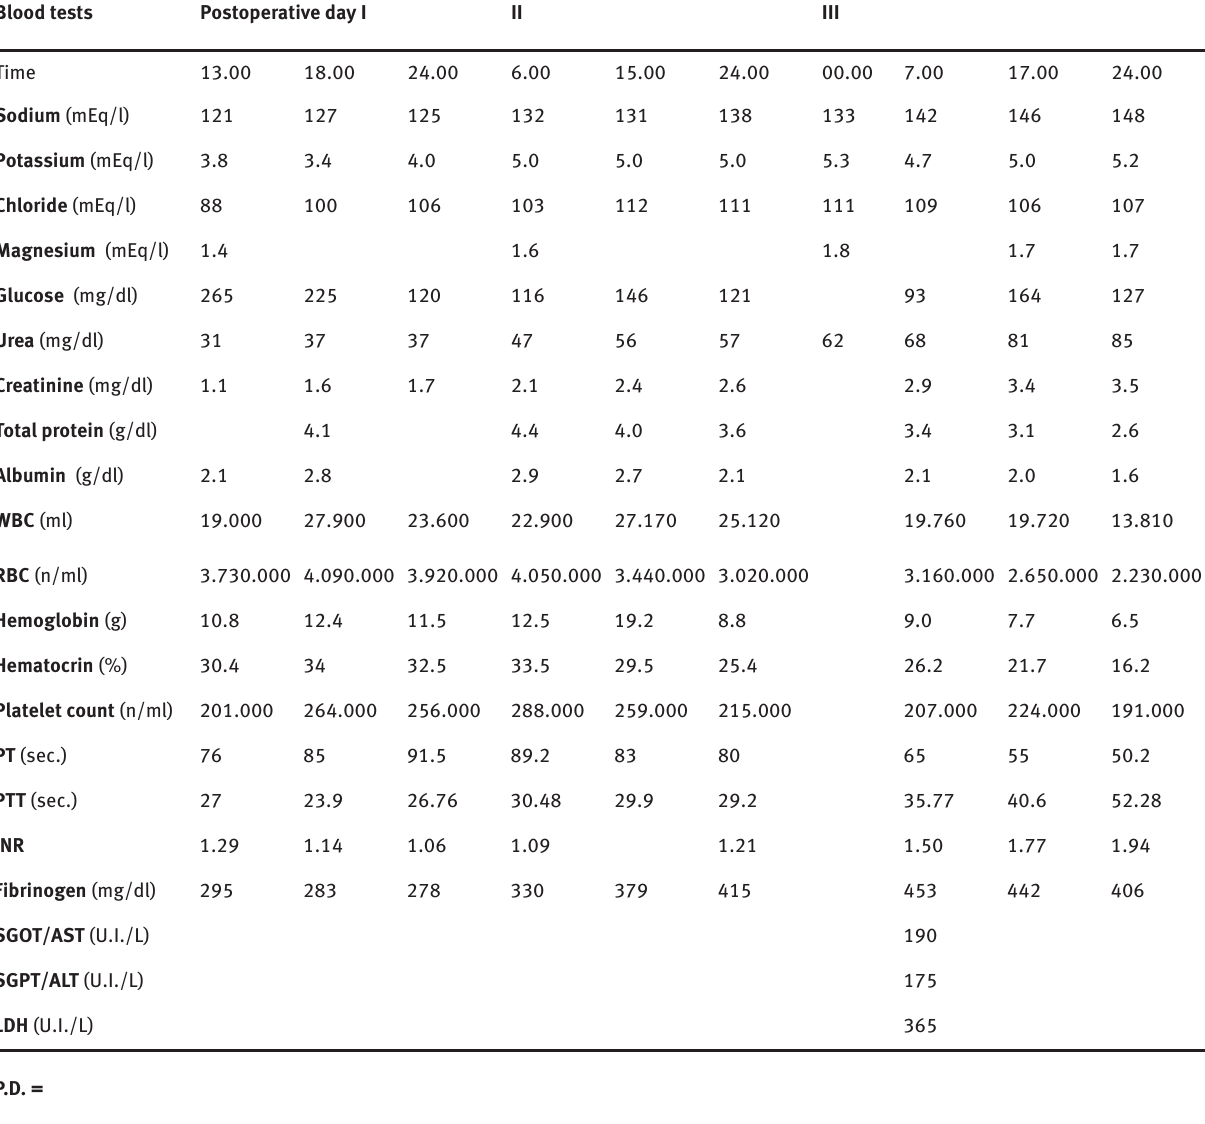
Table 1 : Results of laboratory